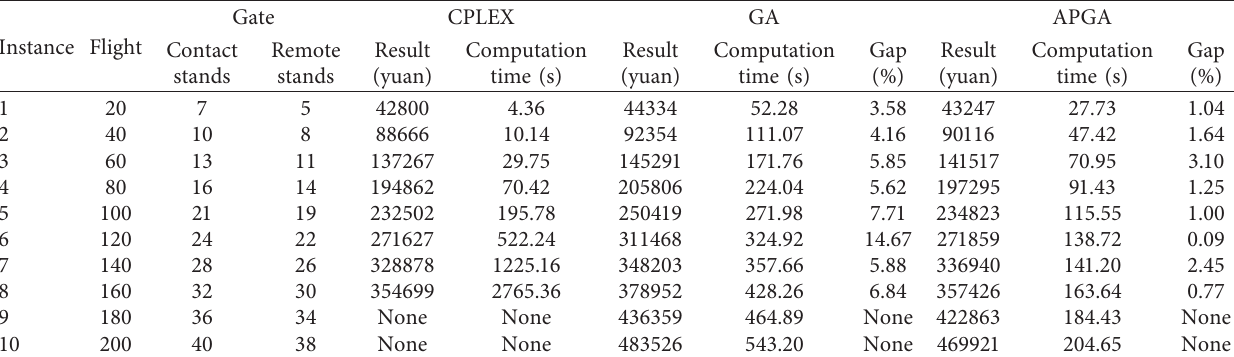
Table 13: Comparison of